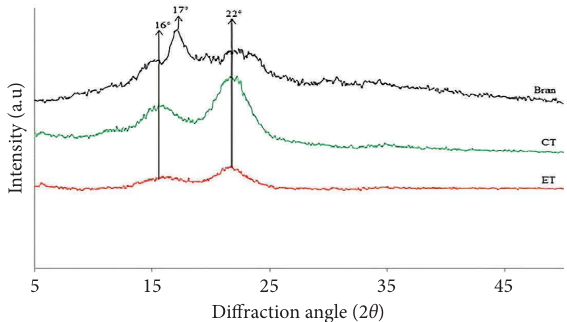
Figure 10: Te XRD pattern showed that the bran sample had a large portion of the amorphous region, indicated by the presence of a peak at an angle of 2 θ � 17 ° as evidence of the presence of starch in the sample. Te XRD spectra of cellulose nanofber by chemical treat- ment ( CT ) and enzymatic treatment ( ET ) interpreted the higher crystallinity of the nanofbers with a crystallinity index of 58.6% and 49.2% [167]. Copyright and permission from